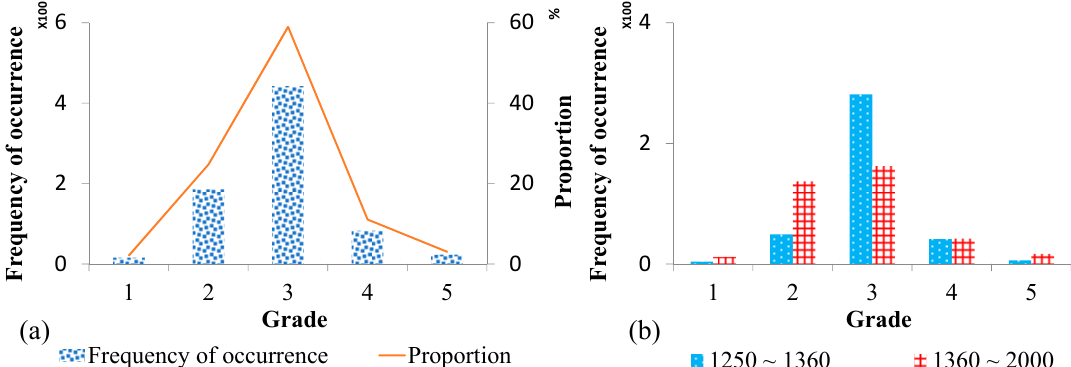
Figure 3. Statistics on the frequency of droughts and floods over past 800 years ( a ) and in two periods, from 1250 – 1360 and 1360 – 2000 ( b ) in Wuzhou City.